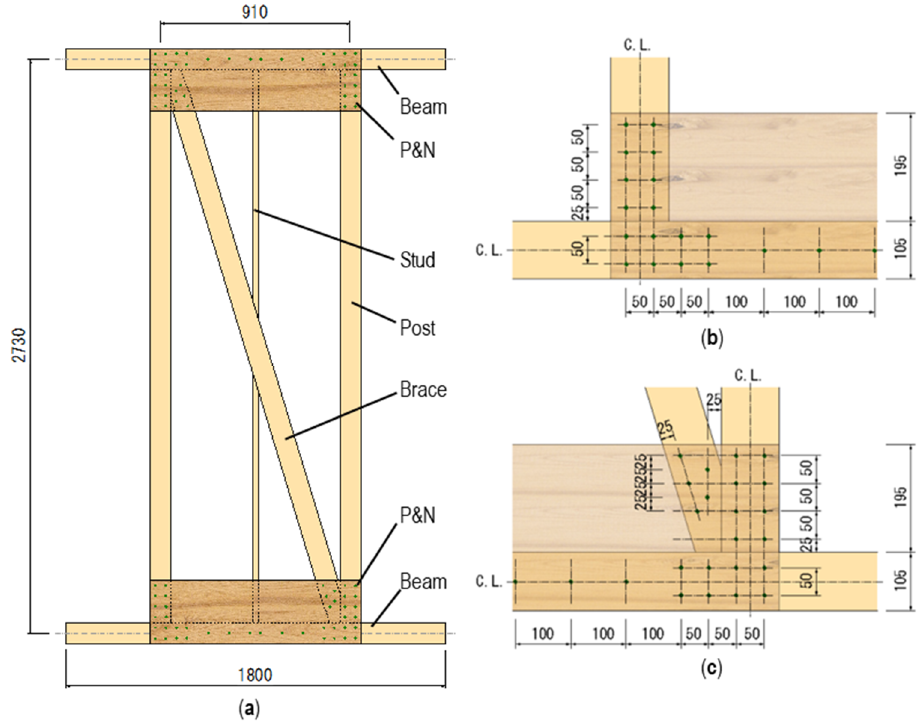
Figure 7. P and N full-scale in-plane cyclic test specimen: ( a ) overall view of the specimen; ( b ) detail of the post-beam connection; ( c ) detail of the post-beam-brace connection; dimensions in mm.